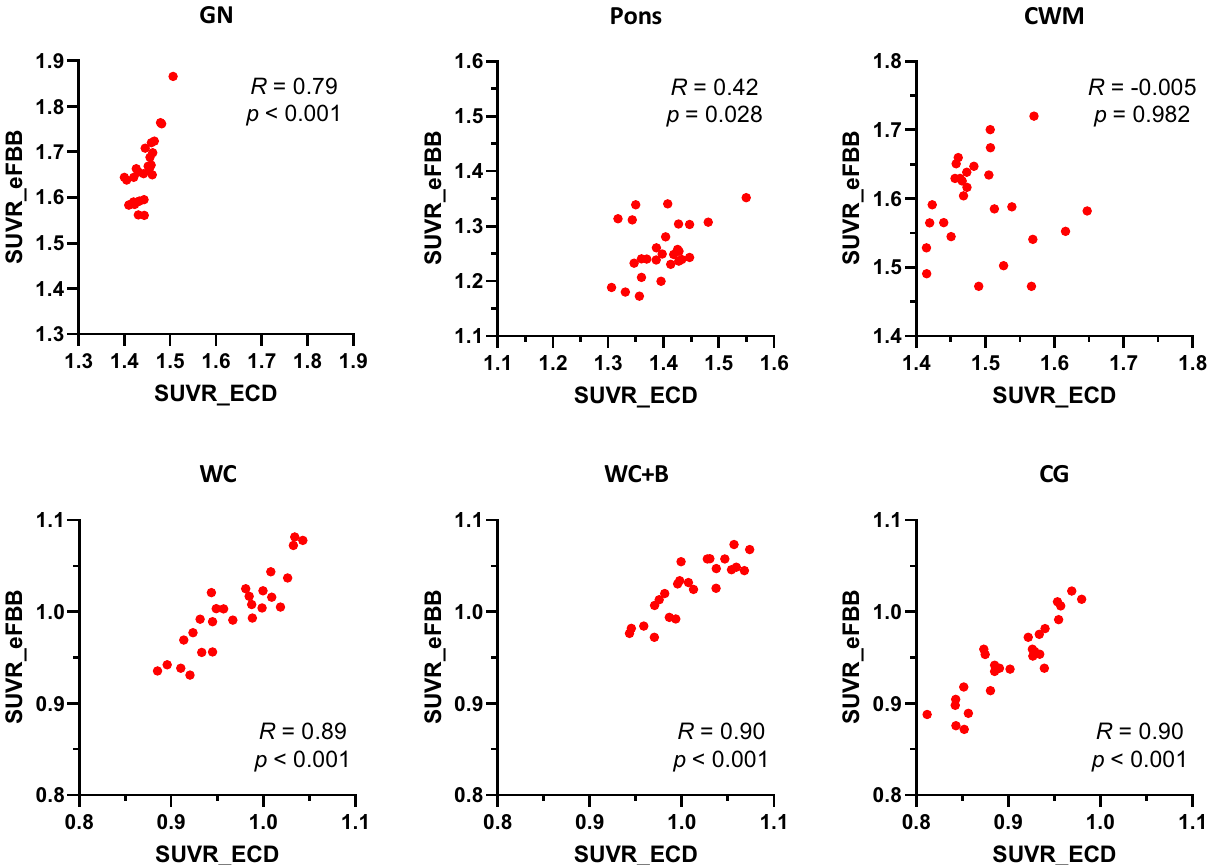
Figure 3. Correlation plots for the Centiloid cortex volume of interest-based SUVR of ECD SPECT versus eFBB PET based on the six reference regions. Pearson’s coefficient r and p values are shown on each plot. Abbreviations CG, cerebellar grey; ECD, Tc-99m ethyl cysteinate dimer single photon emission computed tomography; CWM, central white matter; eFBB, early-phase F-18 Florbetaben positron emission tomography; GN, Global normalization; SUVR standardized uptake value ratio; WC, whole cerebellum; WC + B, whole cerebellum and brain